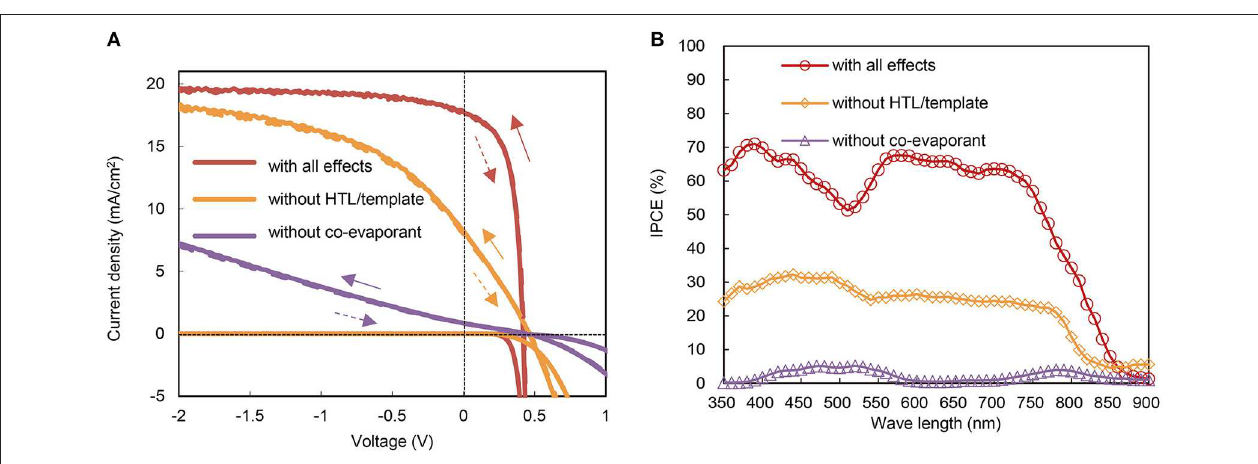
FIGURE 7 | Various effects on photocurrent of OPVs with over-400-nm-thick active layers. (A) Current density–voltage ( J-V ) characteristics of 600-nm-thick ZnPc:C 60 devices with/without effects of lower interfacial layers and crystallization by co-evaporant. Components are with all effects (red), without hole-transfer layer (HTL) and template layer (orange), and without crystallization (purple), respectively. The solid/broken style indicates the voltage sweep direction. (B) IPCE spectra of the same set of the cells. Measurement area is 1.0 cm 2 for J-V curves and 0.04 cm 2 for